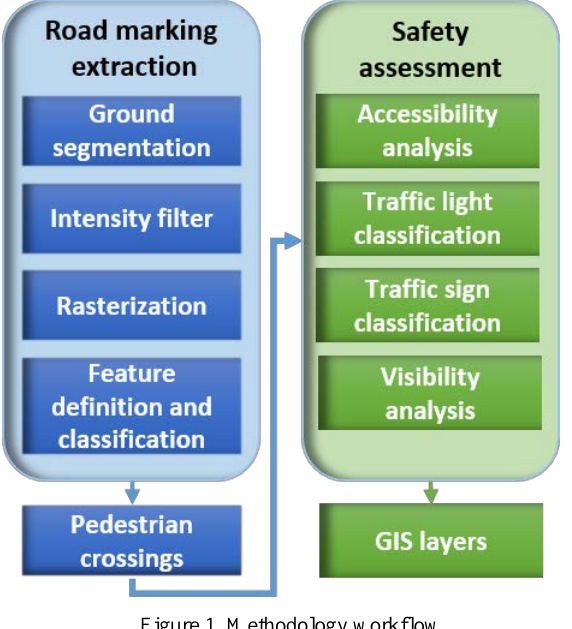
Figure 1. Methodology